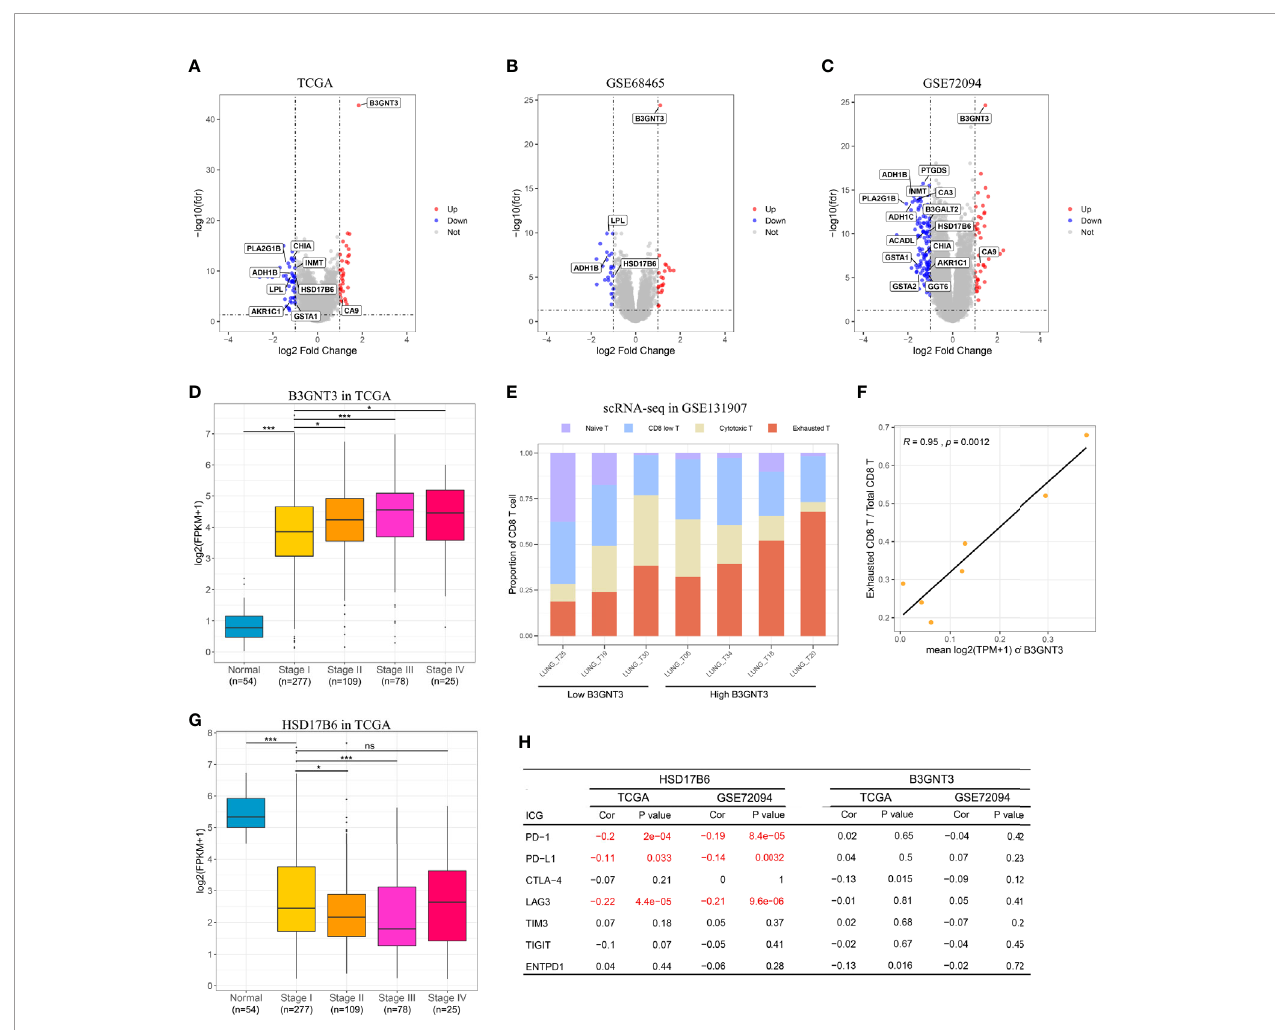
FIGURE 5 | In silico analysis of the MRGPI. (A – C) : Volcano plot showing fold changes for genes differentially expressed between high- and low-risk patients in the TCGA, GSE68465, and GSE72094 cohort. (D) Boxplots of the expression level of B3GNT3 in the normal tissue and different tumor stages showing that upregulation of B3GNT correlated with tumor progression. (E) Proportion of different CD8 + T cell in each patient, and the patients were divided into low and high B3GNT3 group based on the median value. (F) The expression level of B3GNT3 was signi fi cantly associated with the proportion of the exhausted CD8 + T cell. (G) Boxplots of the expression level of HSD17B6 in the normal tissue and different tumor stages showing that down-regulation of HSD17B6 correlated with tumor progression. (H) Pearson ’ s correlation test between B3GNT3, HSD17B6, and immune checkpoint genes. ns, not signi fi cant ( P > 0.05), ** P < 0.01, *** P <